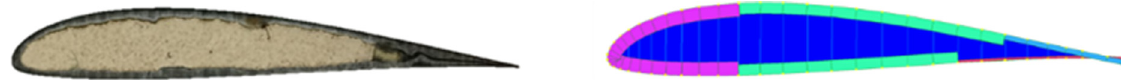
Fig. 2. (a) Physical blade cross-section and (b) blade model cross-section.